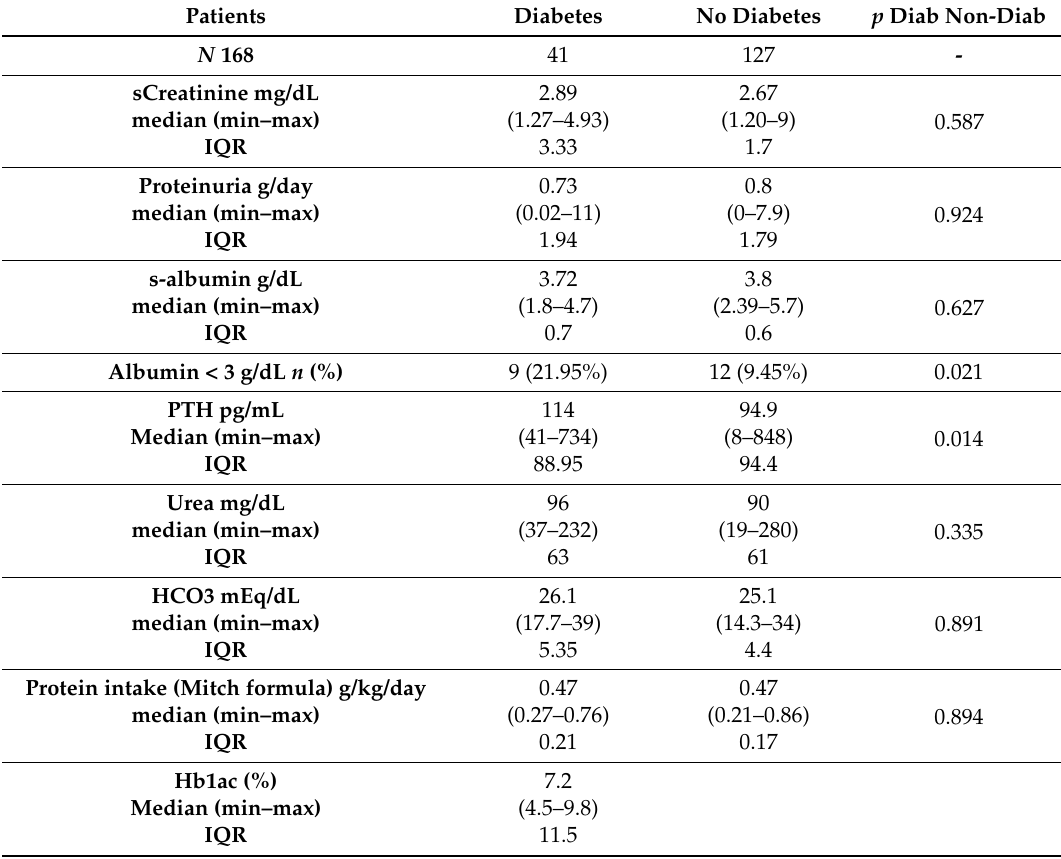
Table 7. Compliance and main biochemical data at the last update: 168 on-diet patients who underwent biochemical profiling before 31 March 2015 (at the San Luigi General